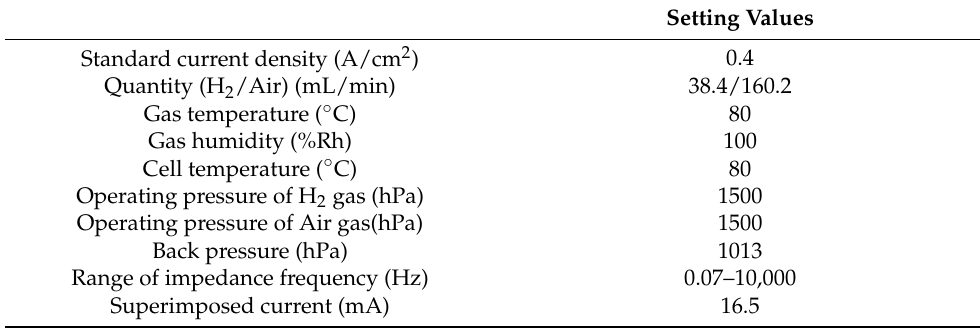
Table 2. Experimental